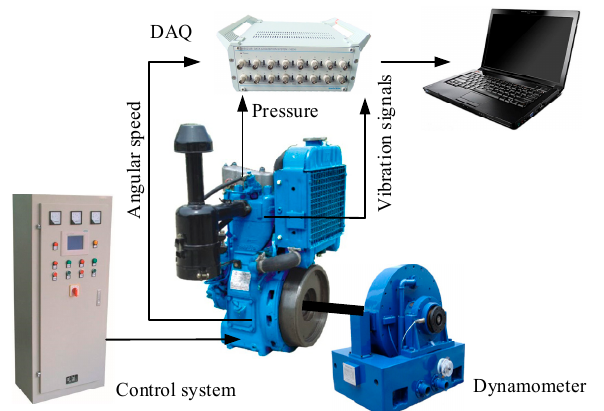
Table 5. Test operating procedure.